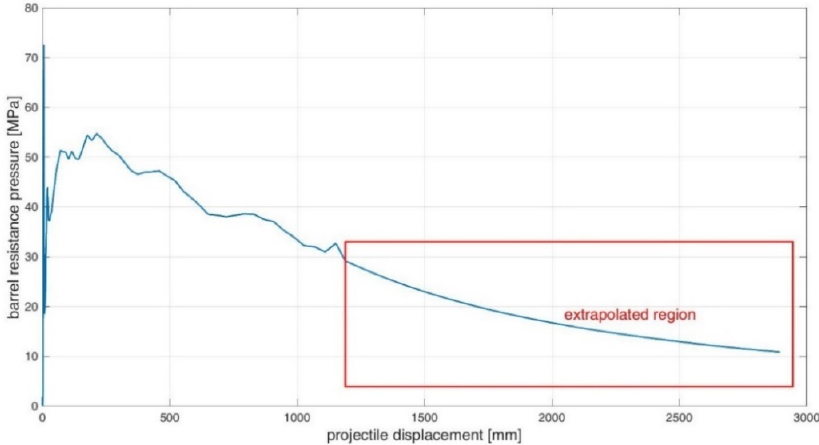
Figure 14. Barrel resistance pressure as function of projectile displacement.